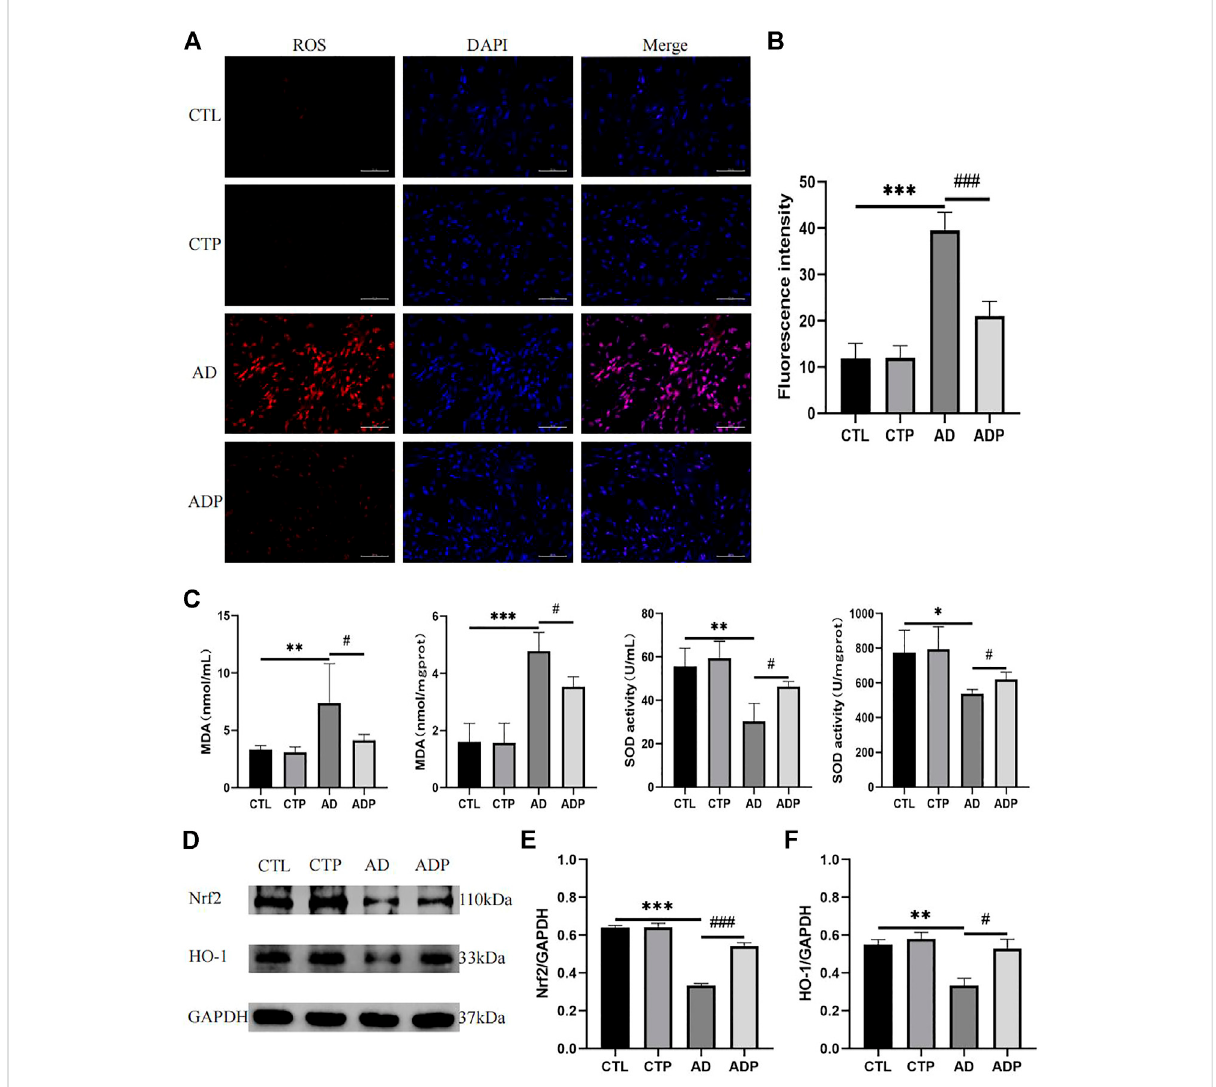
FIGURE 8 Oxidativestress invivo . (A,B) Typicalimagesandrelative fl uorescenceintensityofROSinLA, n =5pergroup. (C) TheconcentrationofMDAand activity of SOD in serum and LA, n = 5 per group. (D – F) Immunoblotting and quantitative analysis of Nrf2, HO-1, n = 3 per